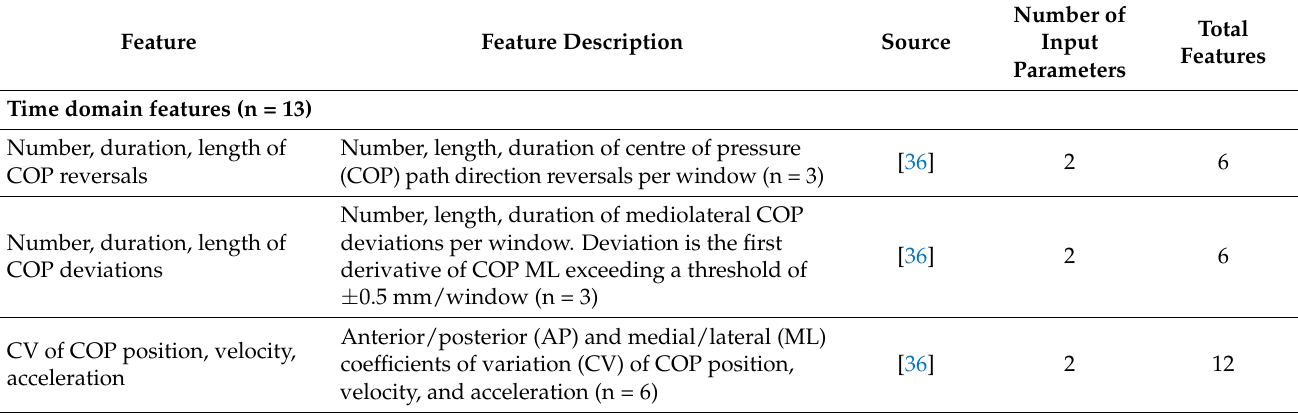
Table 1. Features extracted from windowed